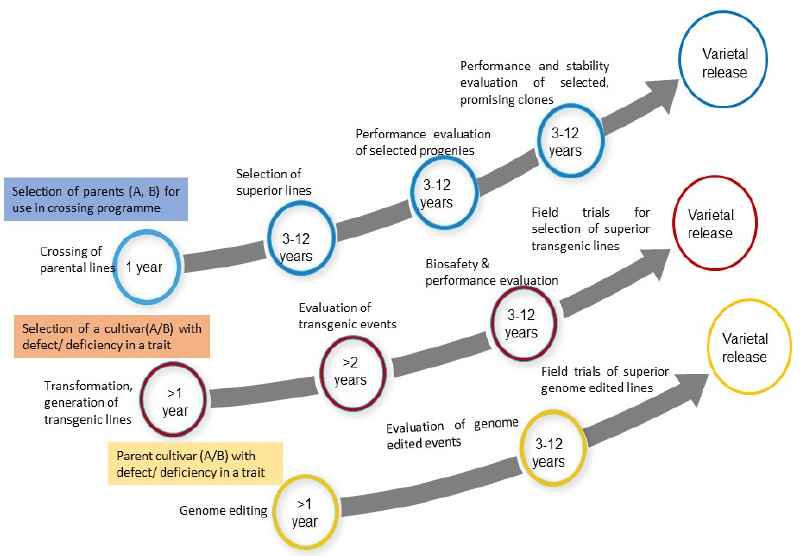
Figure 3. Comparison of conventional breeding, transgenic, and genome editing methods in fruit species [24].